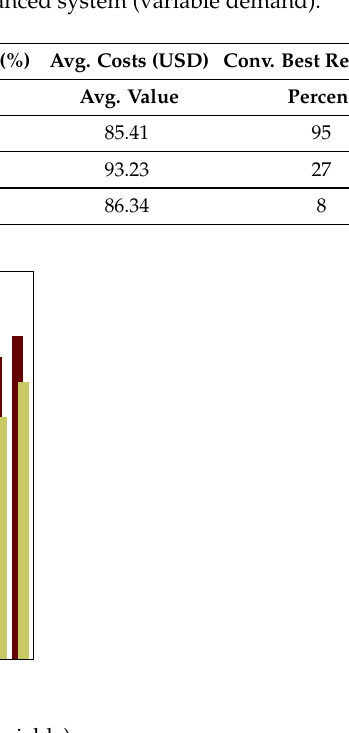
Table 7. Results found for the 69-bus and 73-branch balanced system (variable demand).